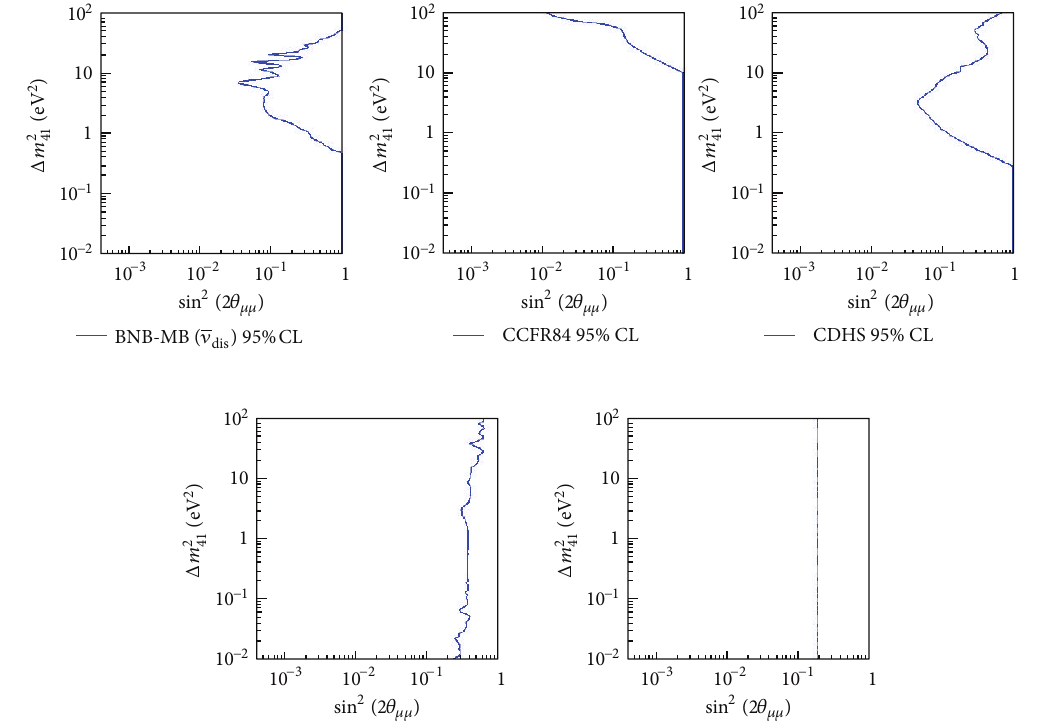
Figure2:Summaryof 𝜈 𝜇 → 𝜈 𝜇 and 𝜈 𝜇 → 𝜈 𝜇 results,shownat95%CL.Toprow:BNB-MB( 𝜈 ATM. See Section 3.2 for details and references.